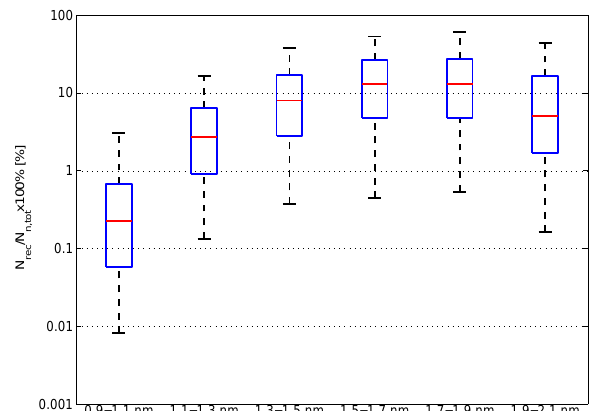
Fig. 3. The percentage of recombination products of all neutral clus- ters in different size classes. The red lines show the medians, the blue boxes indicate the 25th and 75th percentiles, and the vertical bars show the 5th and 95th percentiles.